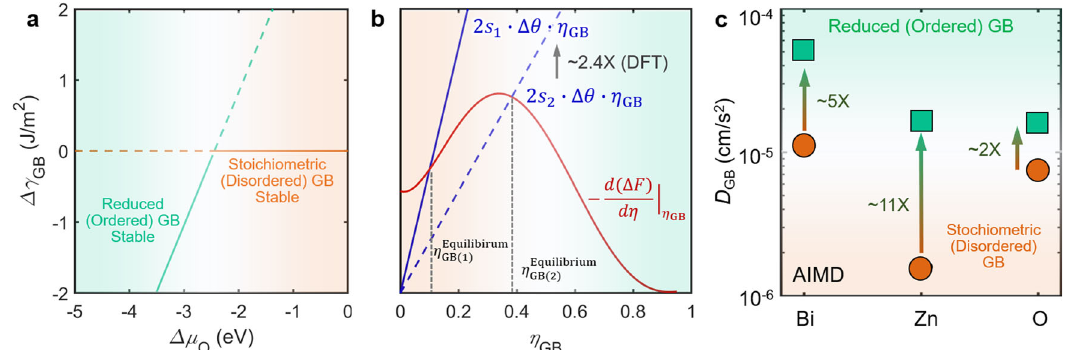
Fig. 6 DFT-calculated interfacial energetical diagram, schematic diagram of GB disorder-to-order transition based on a generalized thermodynamic (cid:2) γ Stoichiometric ( ≡ γ Reduced ) vs. model, and ab initio molecular dynamics (AIMD)-simulated GB diffusivities. a Computed GB energy difference 4 γ GB GB GB (cid:2) 1 E oxygen chemical potential difference 4 μ ( μ ), showing a transition from the stoichiometric (disordered) GB to the reduced (ordered) GB with O 2 O O 2 decreasing oxygen chemical potential, consistent with experiments. b Schematic illustration of a graphical construction method to solve Eq. (2). The intersection of the red and blue lines indicates an equilibrium order parameter, e.g., η Equilibrium . DFT calculations showed that the parameter s for the GB ð 1 Þ stoichiometric GB ( s 1 ) is about ~2.4× of reduced GB ( s 2 ), suggesting that oxygen reduction can lead to larger equilibrium order parameter η Equilibrium and GB ð 2 Þ thus explain the GB disorder-to-order transition. c GB diffusivities calculated by AIMD simulations. The GB diffusivities in the reduced (ordered) GB